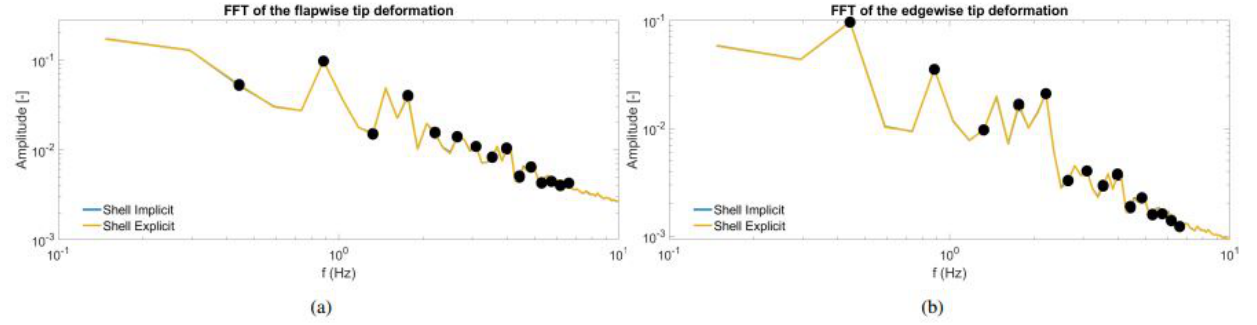
Figure 9. FFT of the flapwise and edgewise blade tip deformation using shell elements with an explicit and implicit coupling algorithm. Circle on the rpm harmonics.